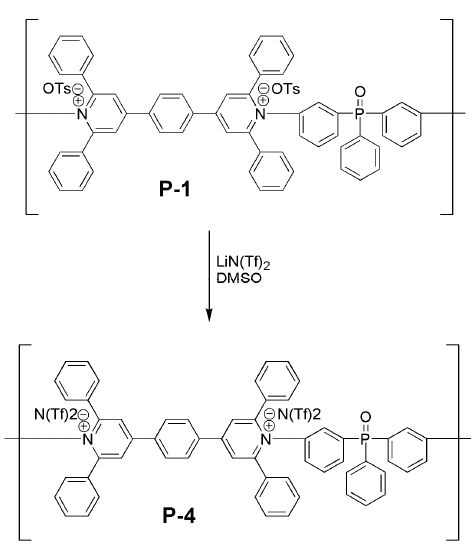
Scheme 6. Metathesis reaction for the conversion of ionic polymer P-1 to P-4 .